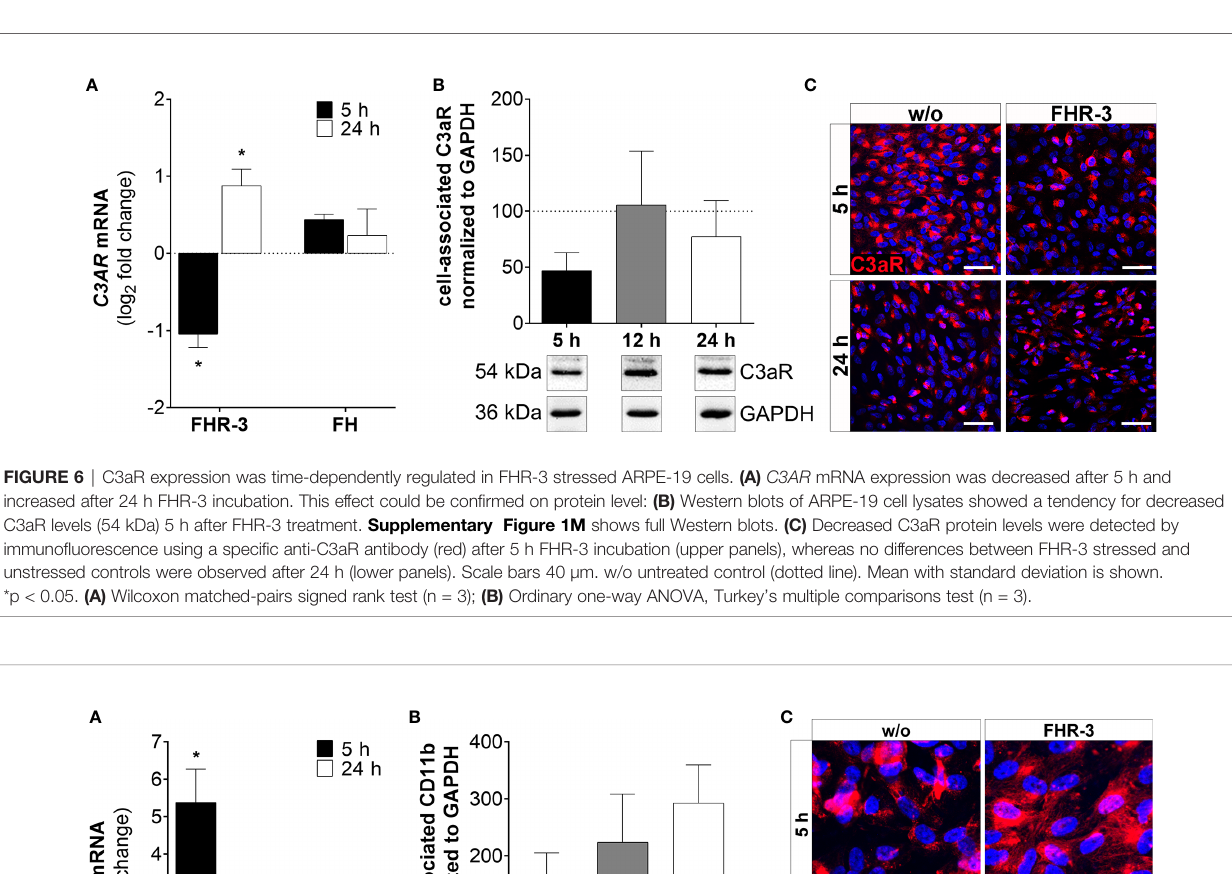
Innotech, San Leandro, CA, USA). Afterwards, Western blots were quanti fi ed against a GAPDH housekeeping protein and calculated using Image Studio Lite (LI-COR).